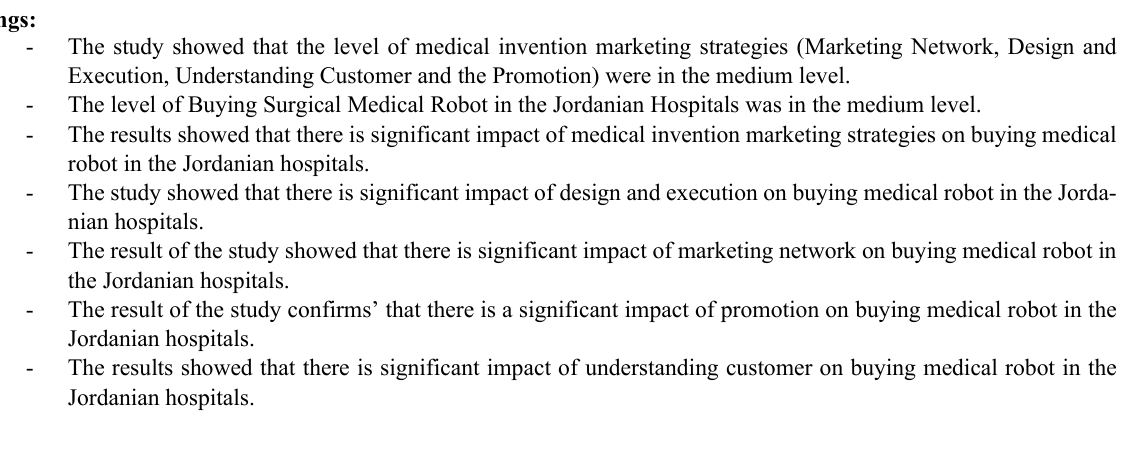
Simple regression to ensure the impact of understanding customer on buying medical robot in the Jordanian hospitals R R 2 B Beta F Value DF Sig 0.269 From Table 7 it is observed that there is significant impact of understanding customer on buying medical robot in the Jordanian hospitals. The R was (0.269), whereas the R 2 was (0.072). This means the (7.2%) of understanding customer impact on